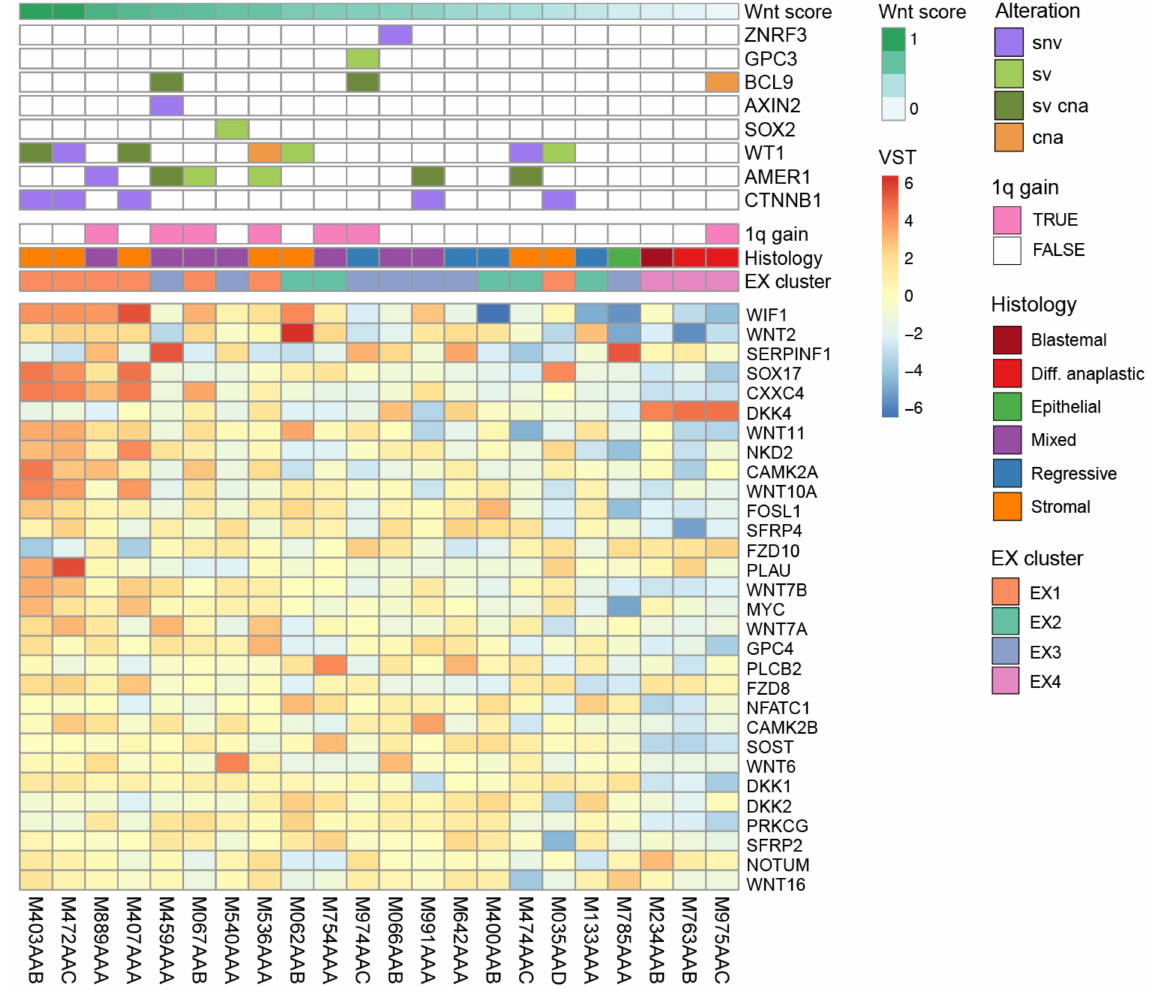
Figure 3. Wnt pathway activation resulting from distinct somatic alterations. Tumors (columns) display a gradient of Wnt pathway activation, ordered from left to right by the normalized mean expression of all Wnt pathway genes (Wnt score). Tumors are annotated with the alterations they carry (colors as in Figure 2C), and according to their 1q gain status, histological subtype and expression cluster membership. The genes (rows) displayed are the top 30 most variably expressed Wnt pathway genes across the cohort (MsigDB